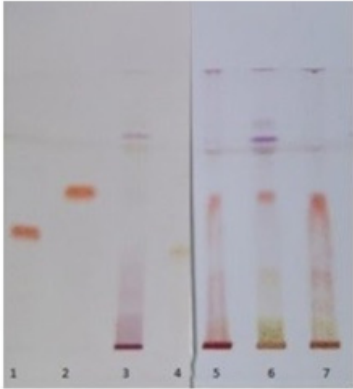
Figure 9. HPTLC elution of the extracts next to catechin, epigallocatechin and epigallocatechin gallate standards (1: epigallocatechin, 2: catechin, 3: red grape pomace extract, 4: epigallocatechin gallate, 5: red grape seed extract, 6: white grape pomace extract, 7: white grape seed extract).